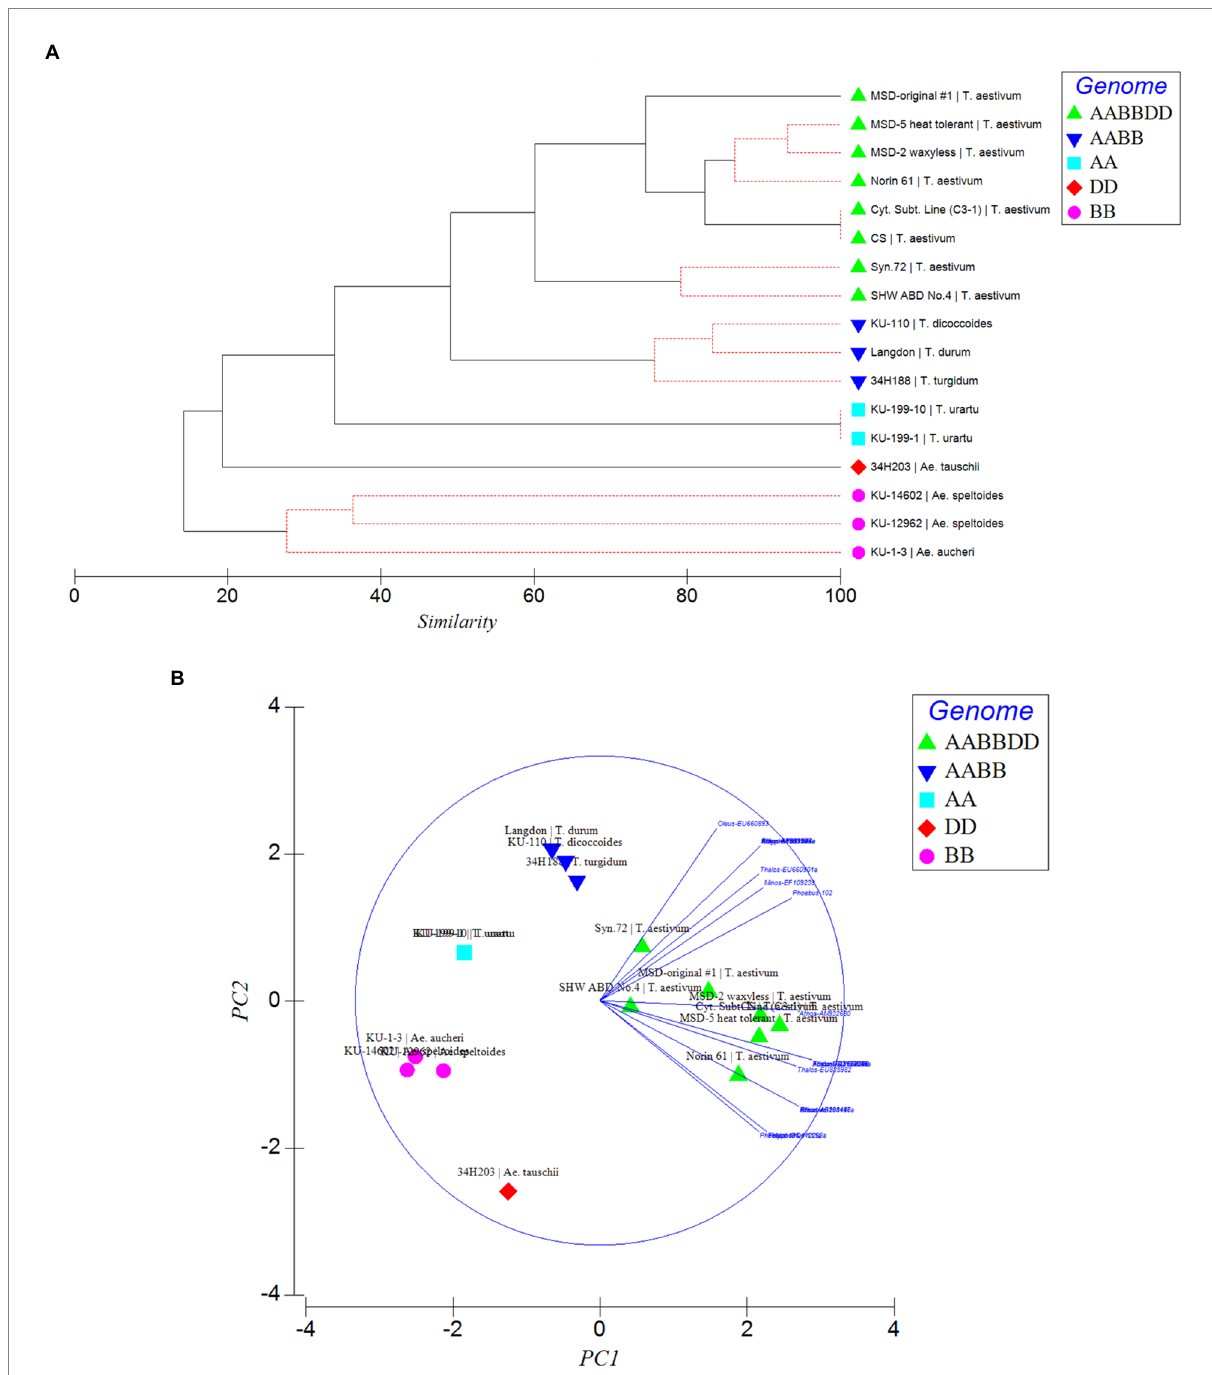
FIGURE 5 Phylogenetic relationships (A) and Principal component analysis (PCA; B ) inferred by MITE insertion polymorphisms in the Triticum–Aegilops complex based on polymorphic “full” sites. Different strata of evolutionary relationships were inferred according to ploidy and genome